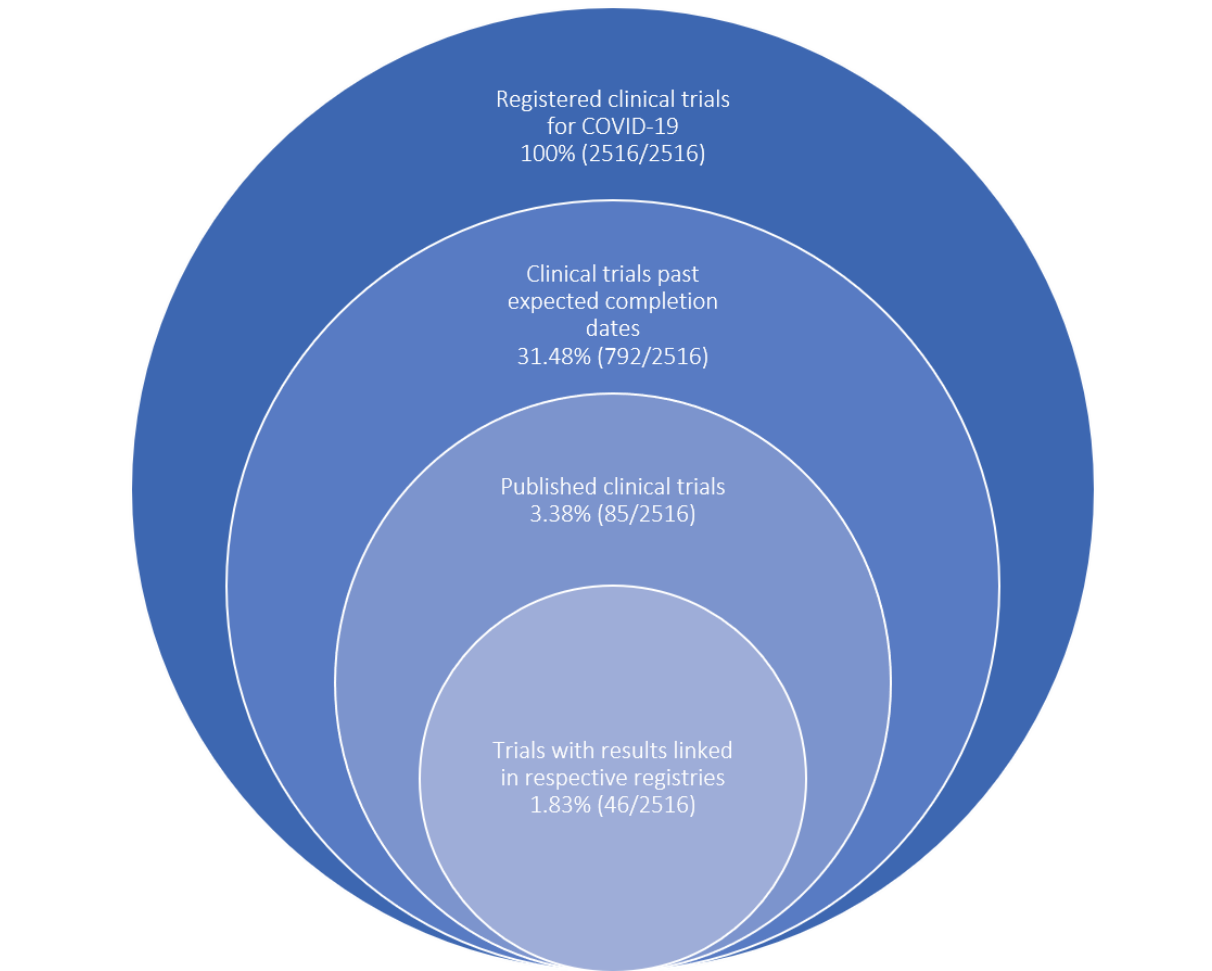
Figure 1. Summary of registered clinical trial status for COVID-19–related